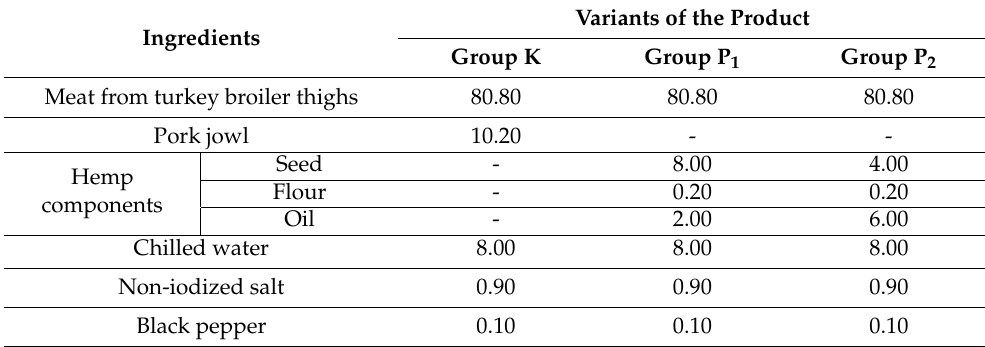
Table 1. Recipe components of the poultry roast